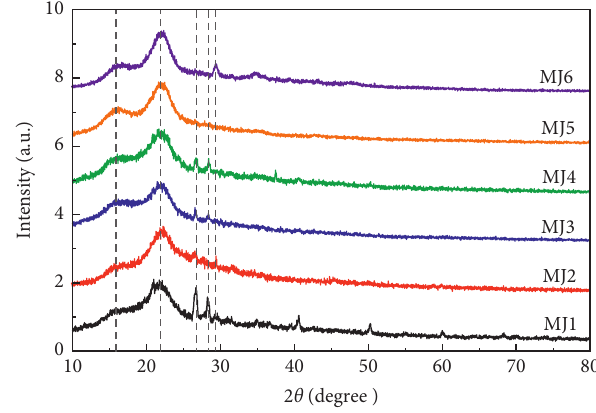
Figure 3: XRD spectrogram of wheat straw fibers before and after modification.